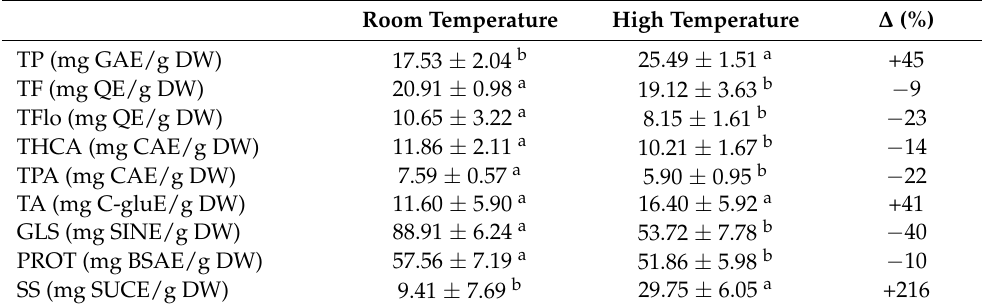
Table 1. Effect of high growing temperature on phytochemical content of broccoli seedlings. Room Temperature High Temperature ∆ (%) TP (mg GAE/g DW) 17.53 ± 2.04 b 25.49 ± 1.51 a +45 20.91 ± 0.98